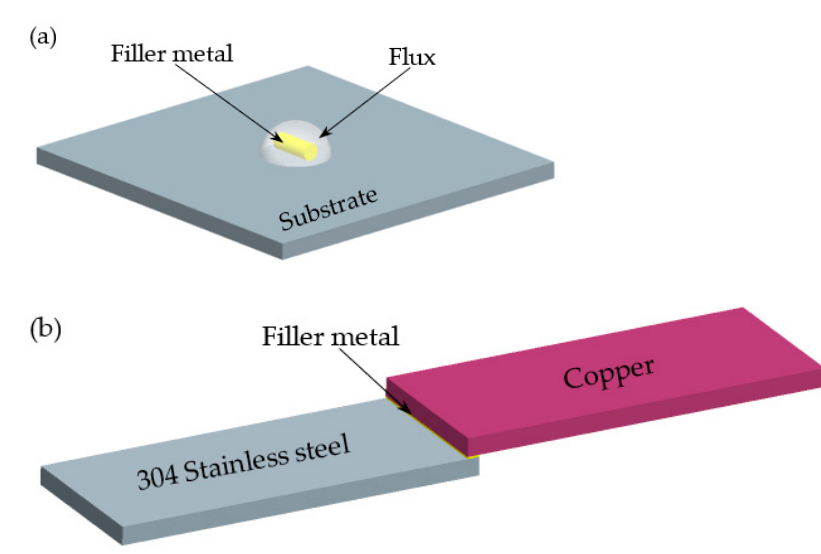
Figure 2. ( a ) Schematic illustration of the spreading specimen; ( b ) schematic illustration of the brazing specimen.